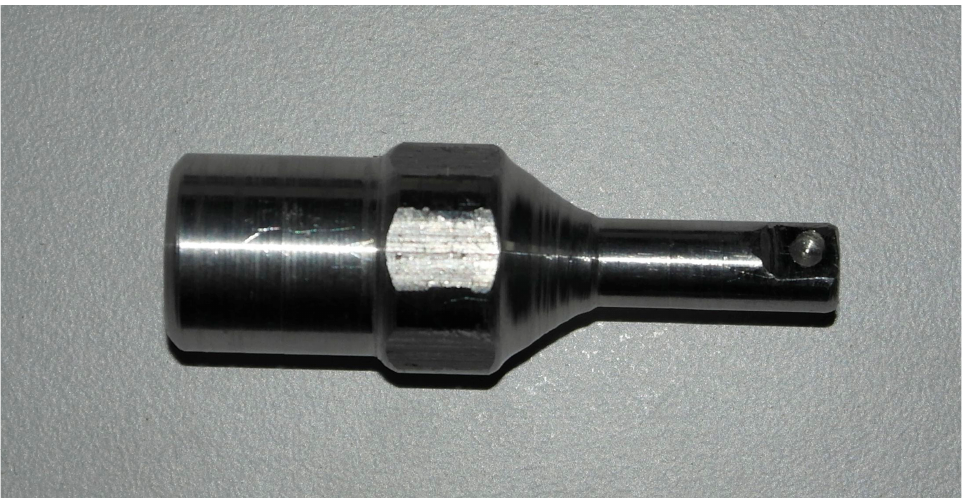
Figure 1. Cryotherapy probe modification.